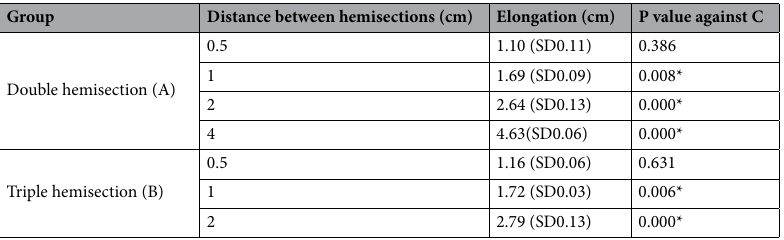
Table 2. Comparison of the elongation of tendons in the double- and triple-hemisection groups (Groups A and B) compared with intact tendons (Group C). The elongation of intact tendon (in group C) was 1.22 (SD0.28) cm. *P < 0.05. The elongation of hemisected tendons where the distance between hemisections was over 1 cm (Groups A and B) was significantly higher than that in intact tendons (Group C).